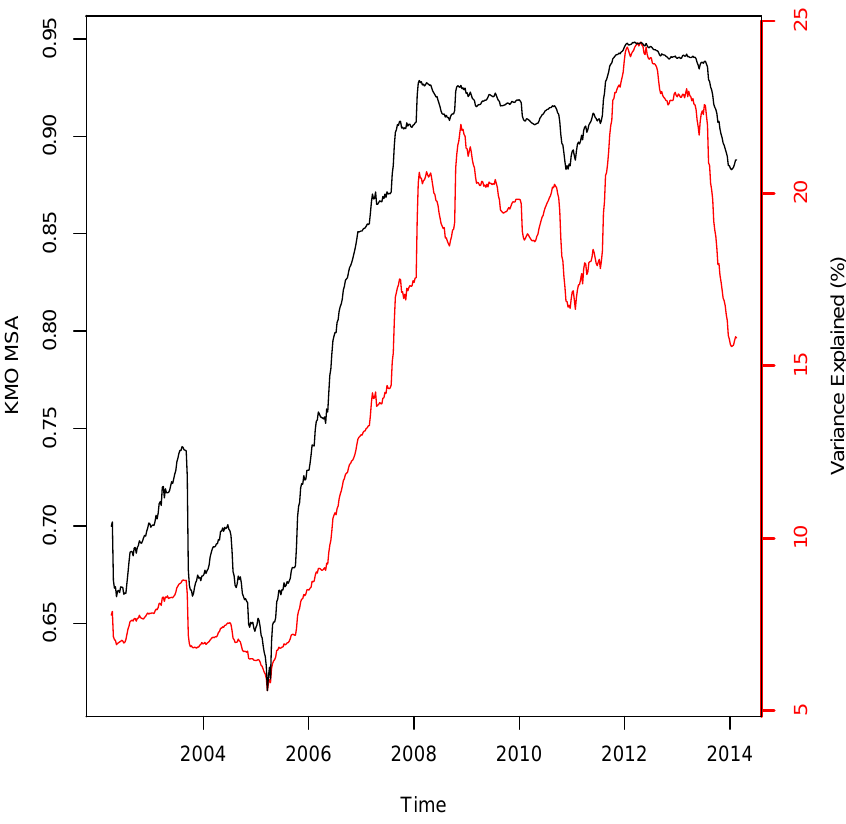
Figure 1. The KMO measure of sampling adequacy for 156 stocks (left hand axis, black line) and the variance explained by PC1 (right hand axis, red line). Both measures were calculated weekly using a rolling window approach with a window size of two years (504 trading